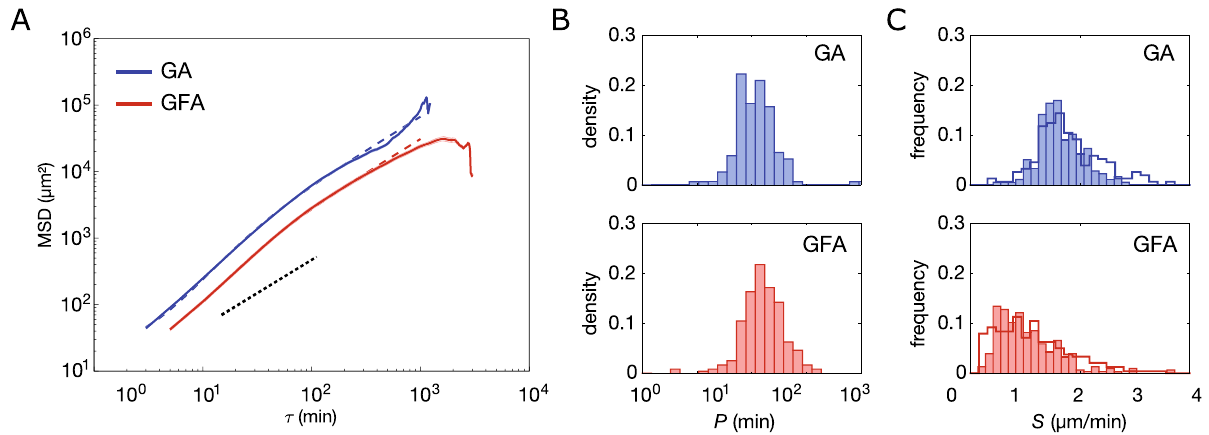
Figure 2. Ensemble-averaged mean-squared displacement analysis. ( A ) GA (N=177) and GFA (N = 305) MSD (τ) (mean ± SEM) on double-logarithmic scale. Dashed lines correspond to fitting of Eq. 2 ( R 2 > 0.99 ). Black punctuated line has a slope of 1, which corresponds to a diffusive motion and is inserted as a guide to the eye. ( B ) Distributions of persistence times, P on a log-normal scale, of the cells in GA ( N = 156 with R 2 > 0.99 and in GFA ( N = 251 with R ). Values are obtained from the msd-analysis described in Eq. (2). ( C